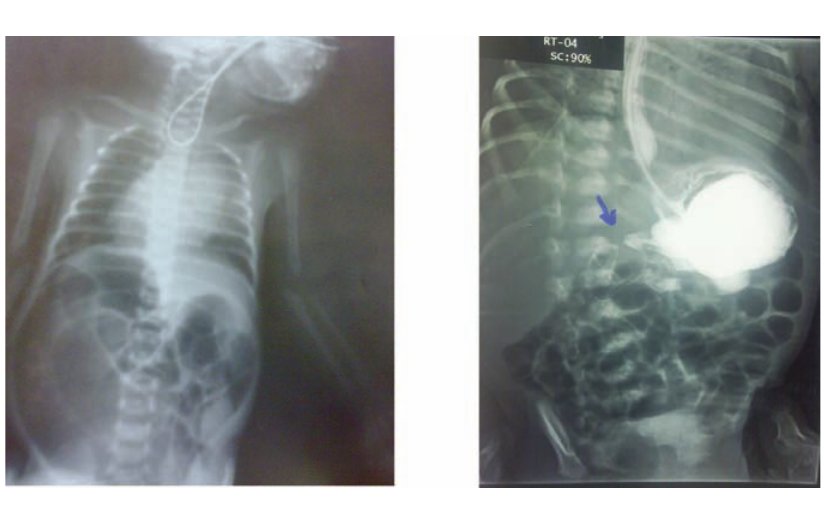
Figure 3. Plane chest and abdomen X-ray. Coiled up orogastric tube; eosophageal atre- sia; gastrographin meal: doudenal